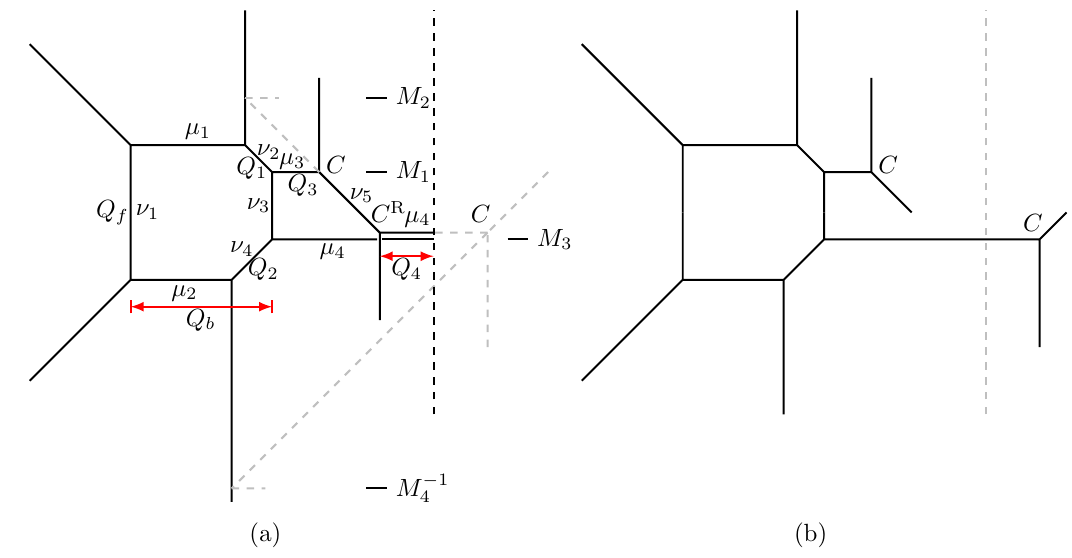
Figure 12 . A 5-brane web for SU(2)+4 F as a D 3 -quiver, SU(1) − SU(2) − SU(1). The vertical dotted line represents an ON −